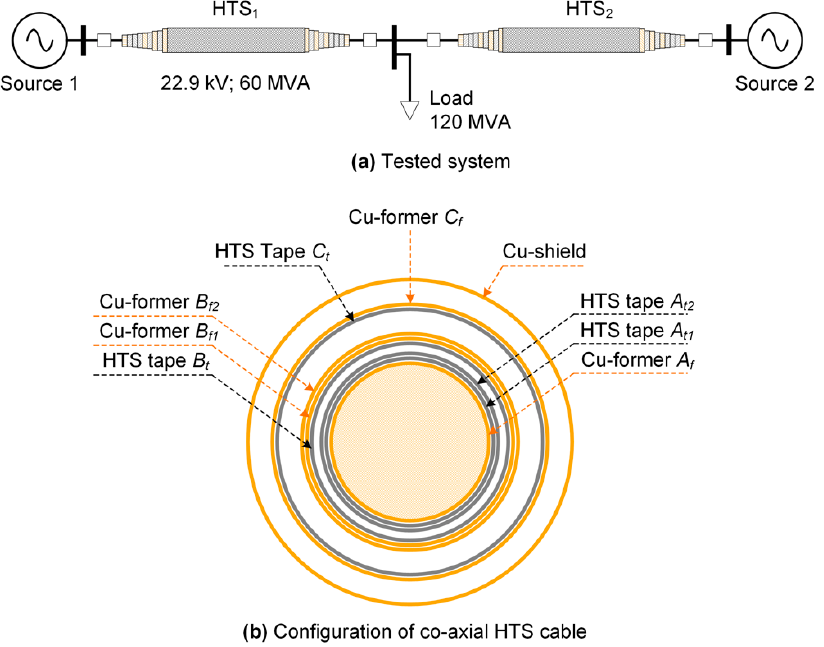
Figure 1. Tested system and configuration of co-axial high-temperature superconducting ( HTS) cable.